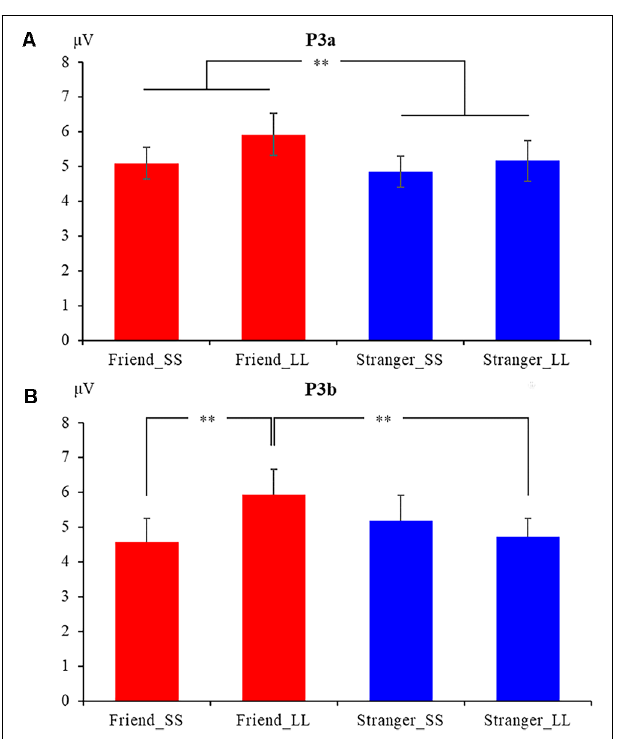
FIGURE 5 | The mean amplitudes of P3a (A) and P3b (B) at nine electrodes under four conditions. ∗∗ p < 0.05.